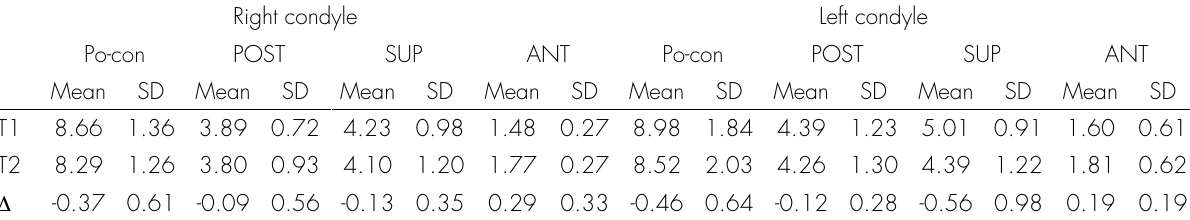
Table Vb. Condylar position at T1 and T2 in the patients with transverse Rotating condyle Orbiting condyle Po-con